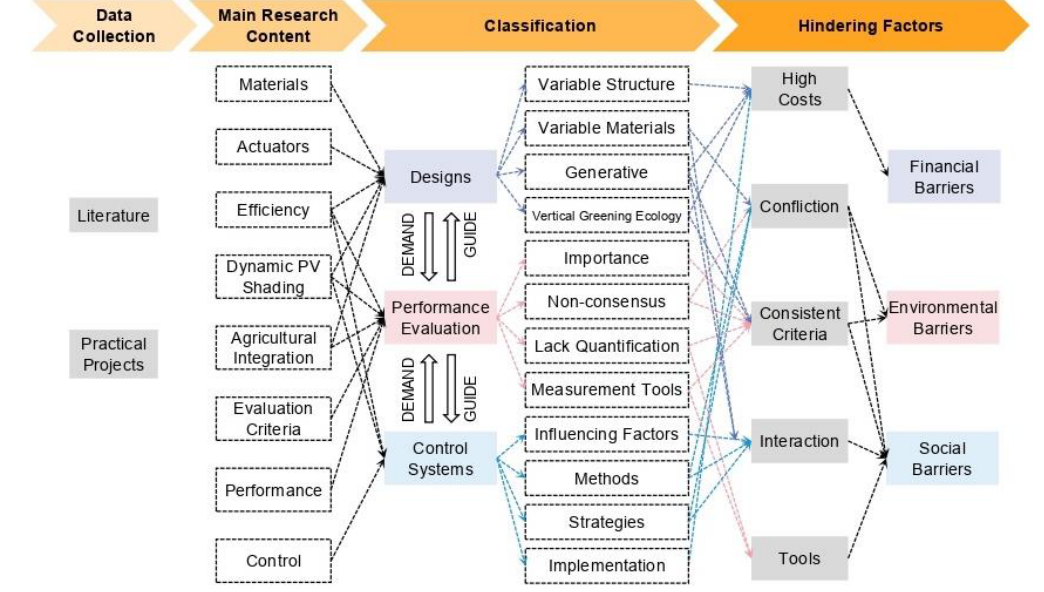
Figure 2. The main structure of this paper.